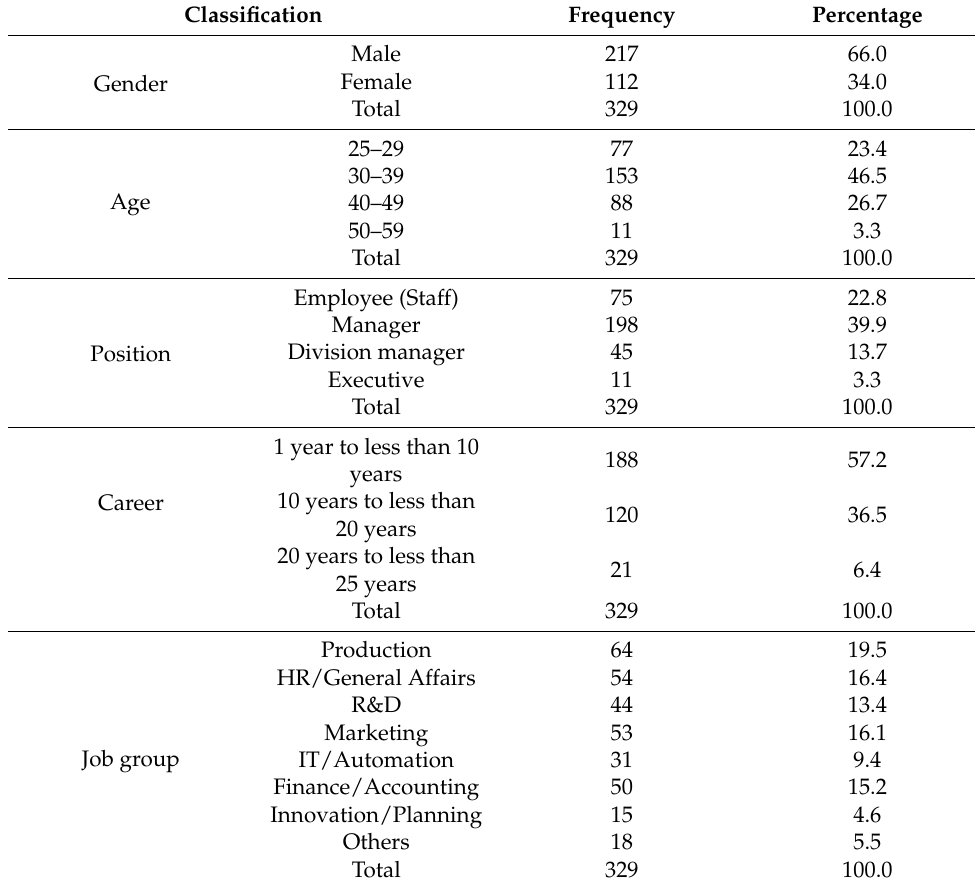
Table 2. Demographic information of survey